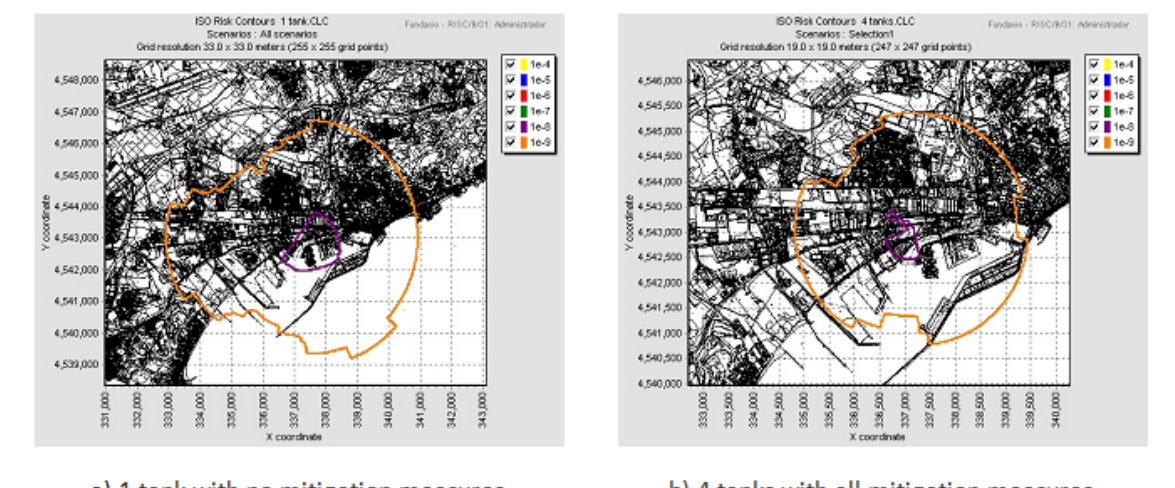
Figure 2. Example of risk curves of a Quantitative Risk Analysis. Each curve represents the affectation areas where the risk is constant